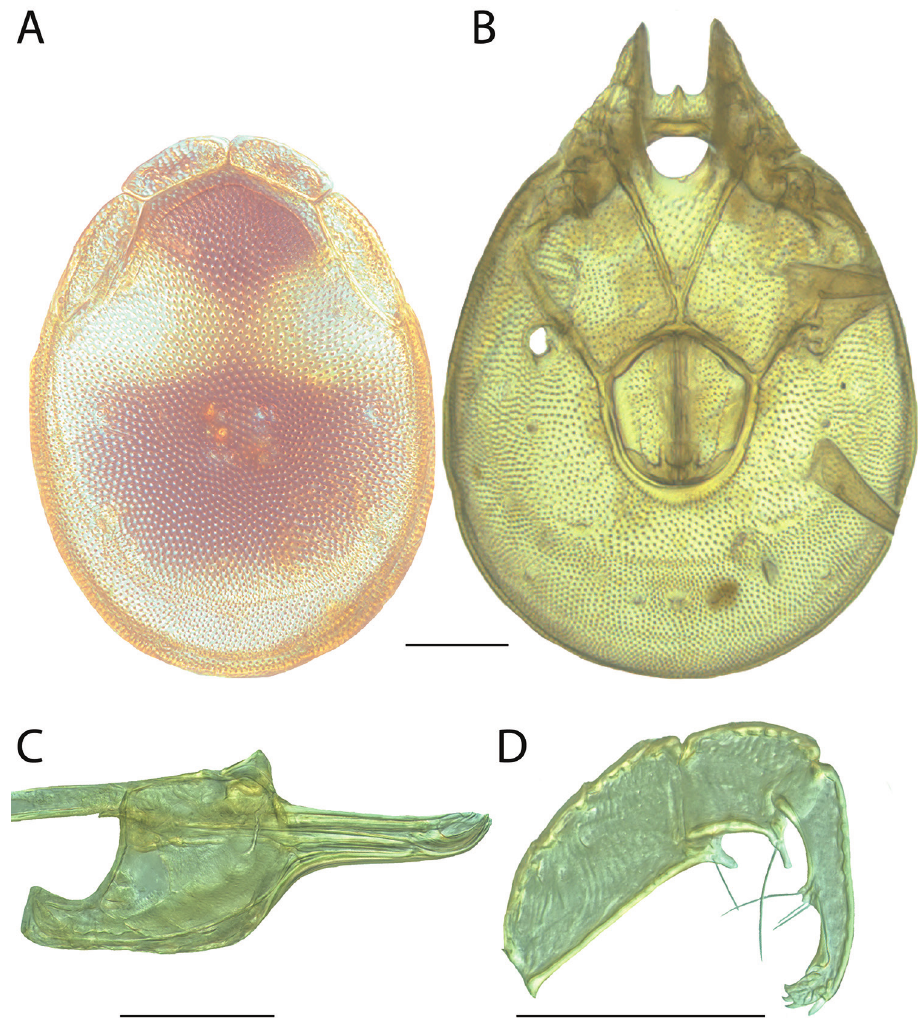
Figure 194. Torrenticola pollani sp. n. female: A dorsal plates B venter (legs removed) C subcapitulum D pedipalp (setae not accurately depicted). Scale = 100